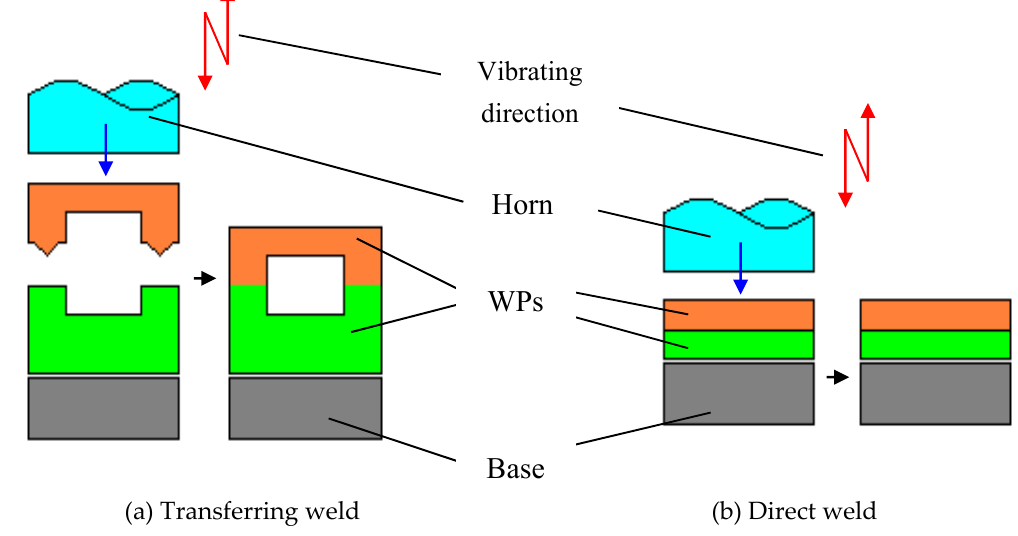
Figure 2. Conventional USW methods. Adapted from Reference [99].